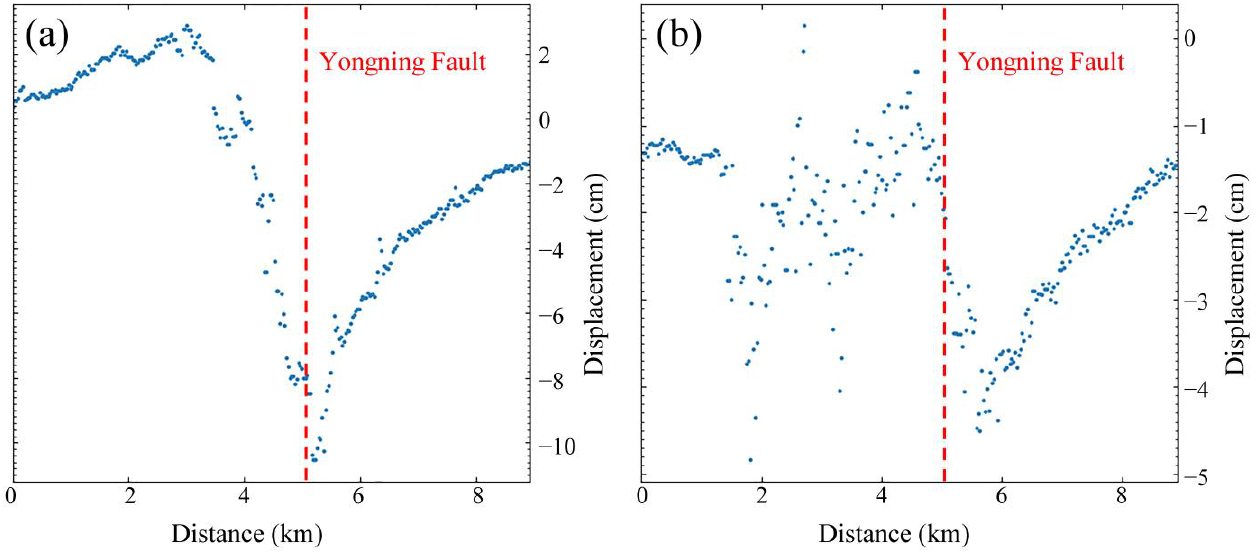
Figure 5. ( a ) the coseismic deformation profile of the ascending orbit; ( b ) the coseismic deformation profile of the descending orbit.